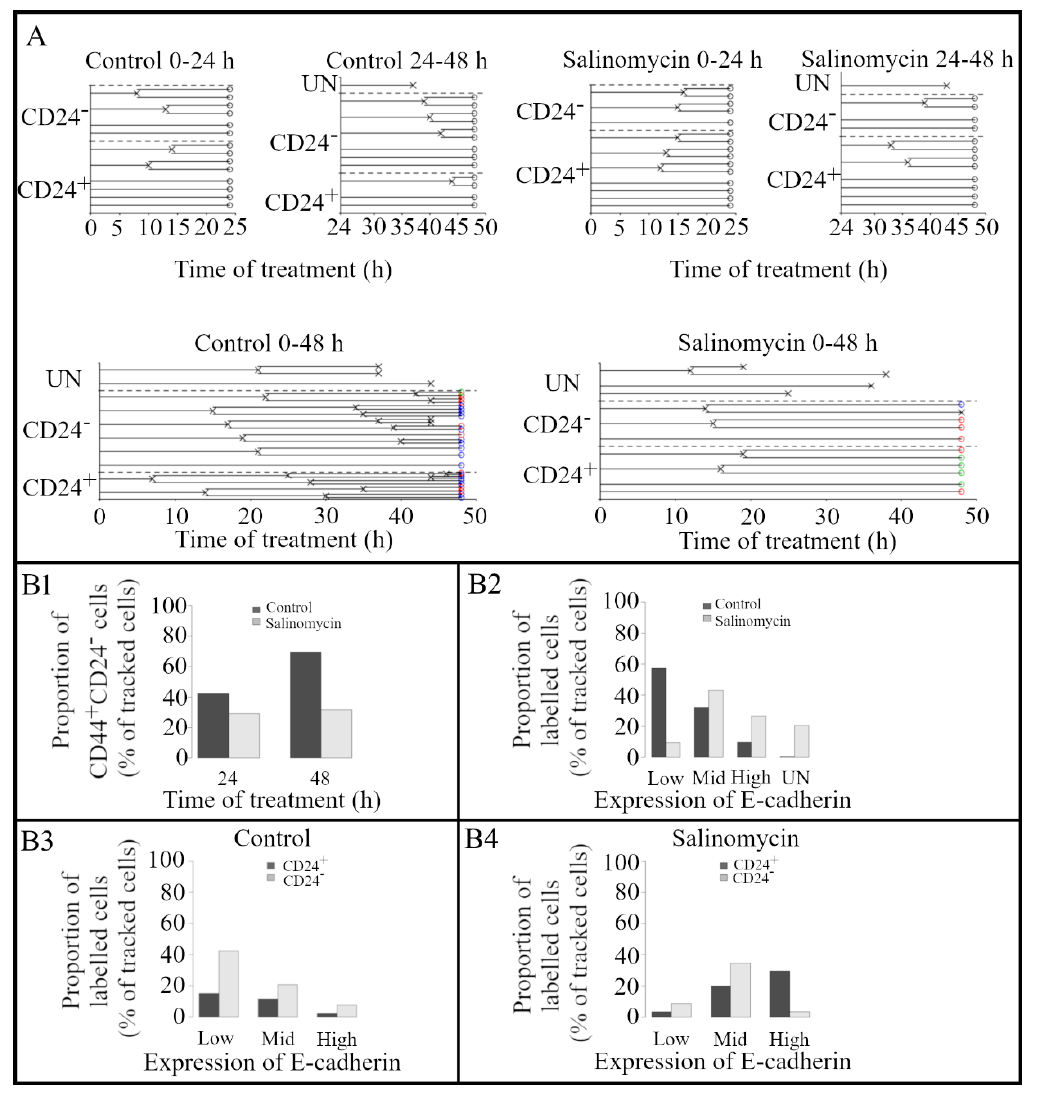
Figure 2. Longitudinal tracking combined with fluorescence imaging of JIMT-1 cells cultured in the absence or presence of 0.5 µM salinomycin. ( A ) Longitudinal tracking of digital holographic microscopy (DHM) time-lapses displayed as representative cell family trees based on the original data in Figure S2. The dashed lines in each panel separate the CD24 + and CD24 - cell populations as well as the unknown cells (UN, no label). The expression of E-cadherin is represented as colors of the end-circle in the 0–48 h panels, red = low, blue = medium, and green = high. O: known expression of fluorescence, X: unknown expression due to division before end of the time-lapse, clumping of cells or leaving the frame before the end of the time-lapse. ( B1 – B4 ) Proportion of JIMT-1 cells designated into different groups depending on their expression of fluorescence at 48 h. The data are compiled from all data shown in Figure S2. They are derived from 3 independent experiments with 2 independent time-lapses in each.